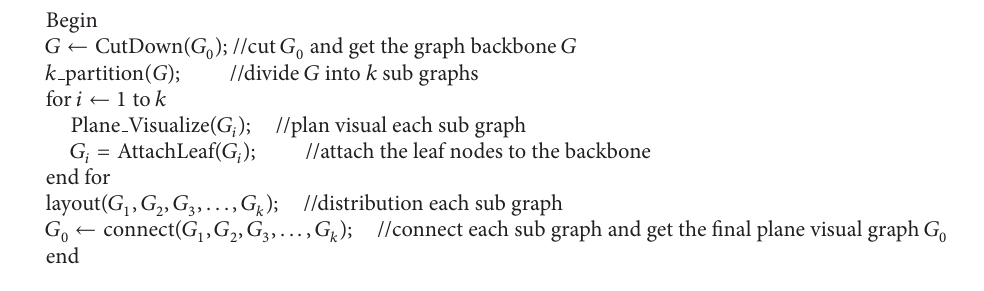
Algorithm 1: Plane visual